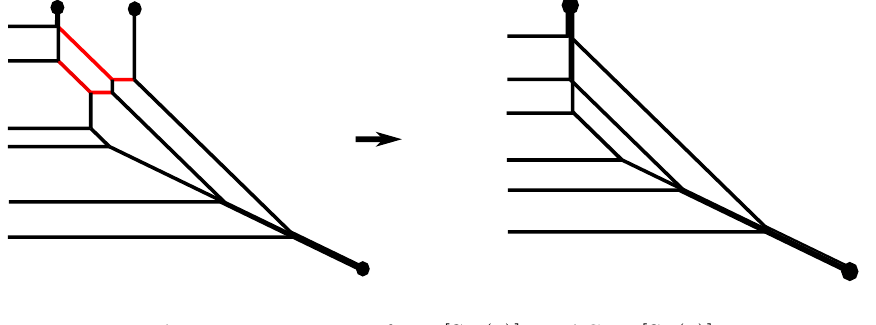
Figure 30 . Higgsing from [SU(6)] (cid:0) 1 AS to